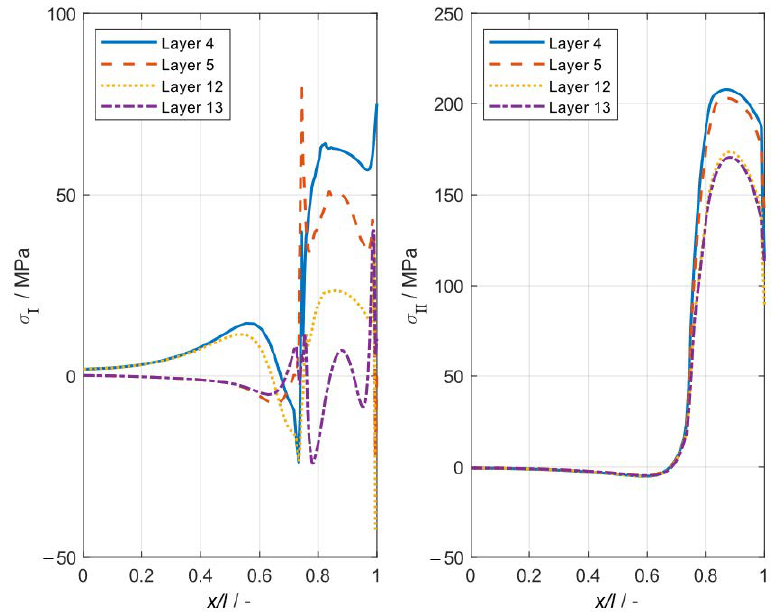
Figure 7. Longitudinal and transverse residual stresses along the x-direction in 90° layers at the specimen center y = 0.5 w .